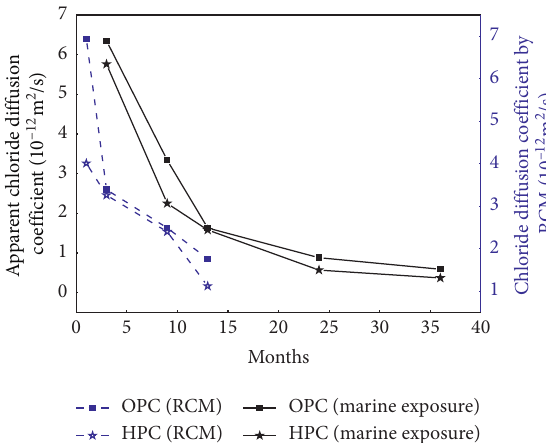
Figure 6: D RCM and apparent chloride diffusion coefficient of OPC and HPC.